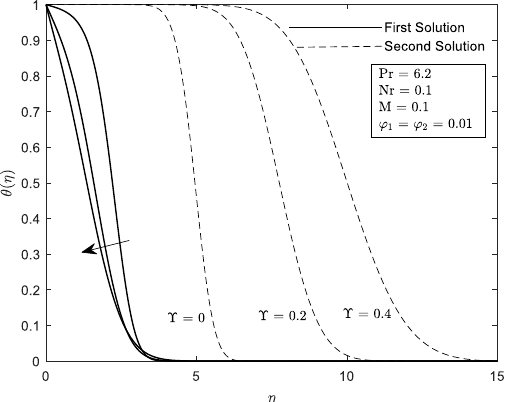
Figure 22. 𝜃(𝜂) on different ϒ .